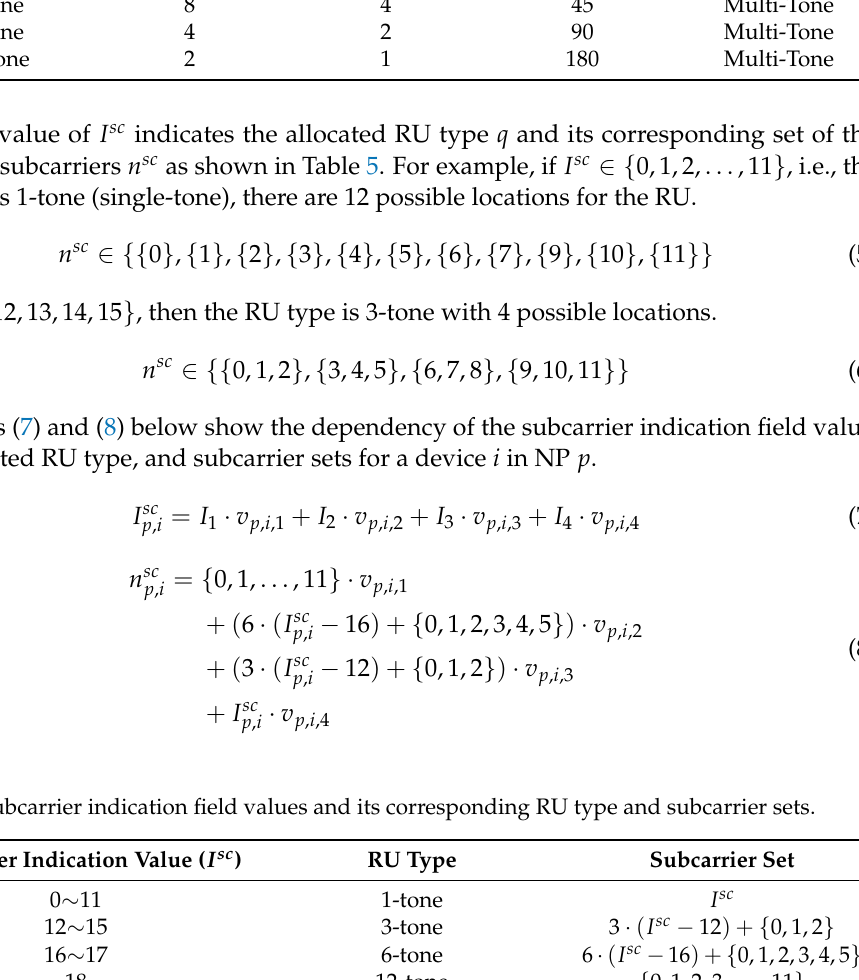
Table 4. Characteristics of the different RU types for subcarrier spacing = 15 kHz. Number Number RU RU of Tones of Duration Bandwidth (RU Type) Timeslots